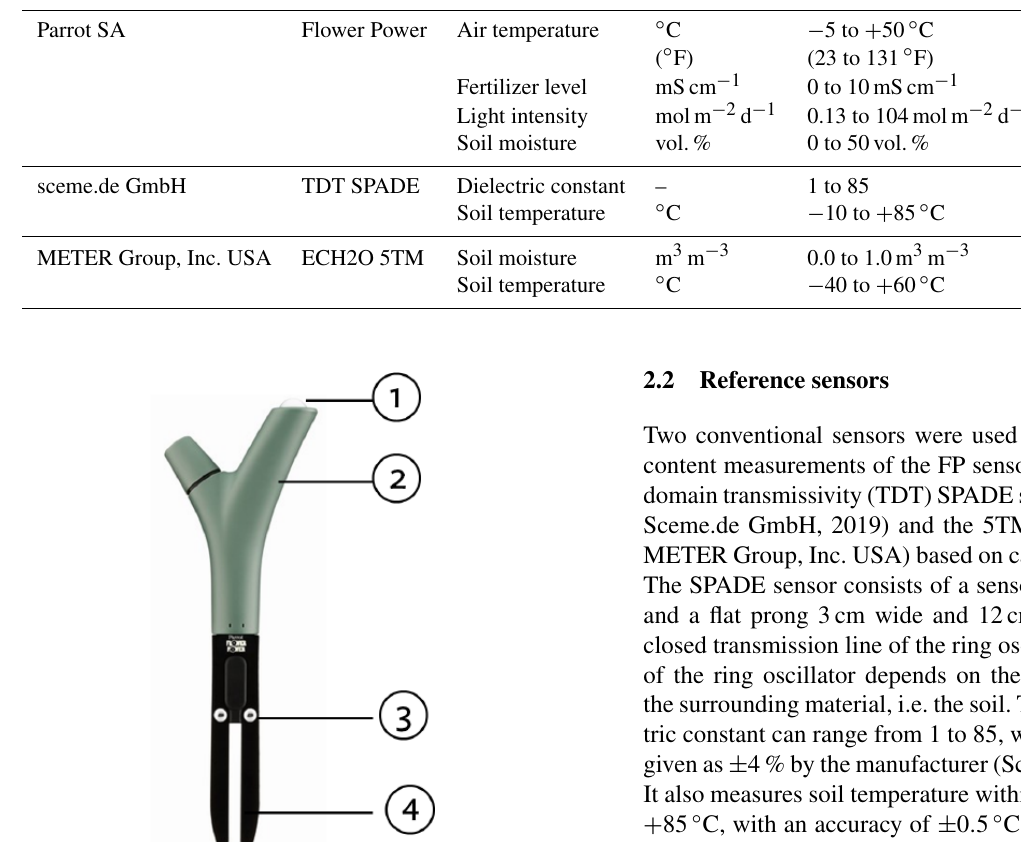
Table 1. Variables, unit, range, and accuracy of the used soil moisture sensors as specified by the manufacturer. Producer